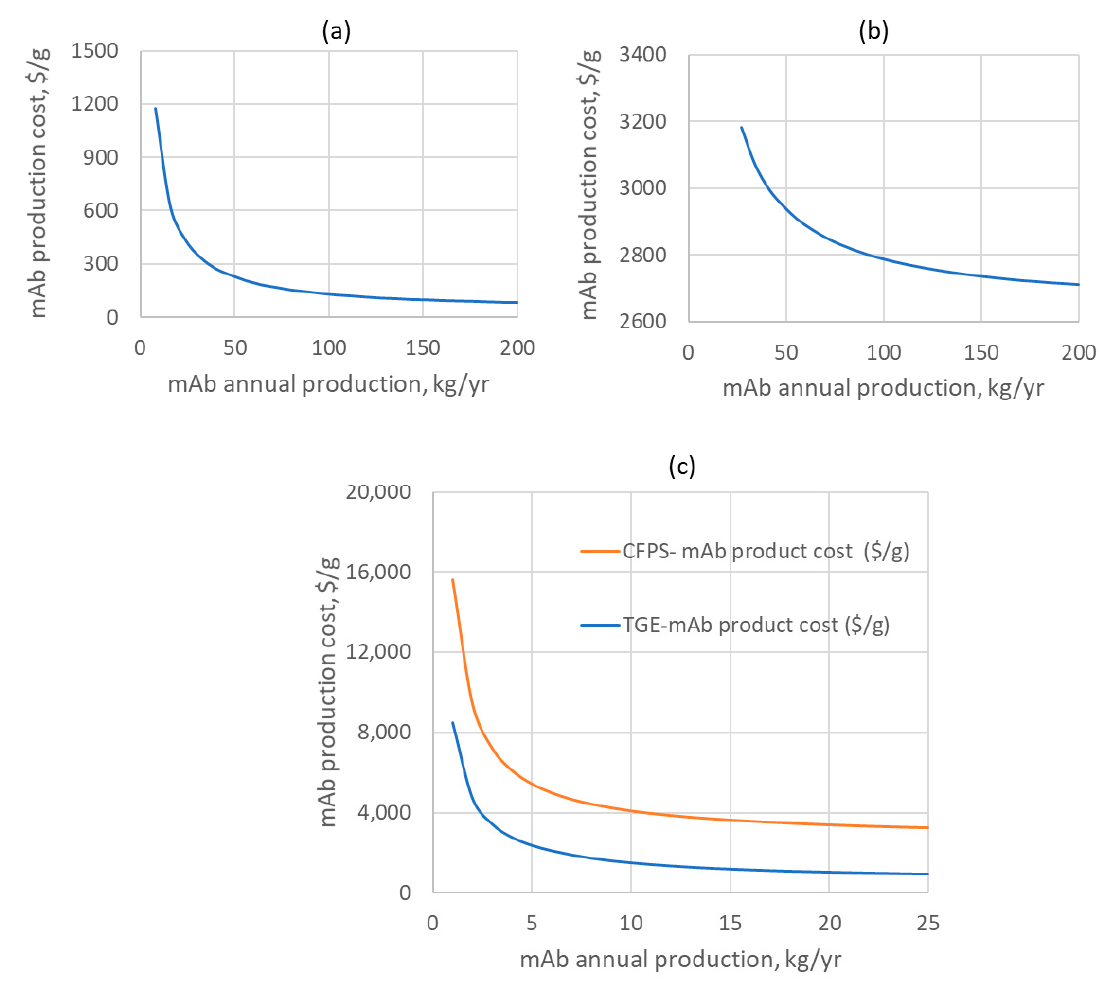
Figure 3. The mAb production cost versus the annual throughput capacity for ( a ) SGE from 8 to 200 kg/yr; ( b ) large-scale CFPS from 27 to 200 kg/yr; and ( c ) small-scale TGE and CFPS from 1 to 25 kg/yr.